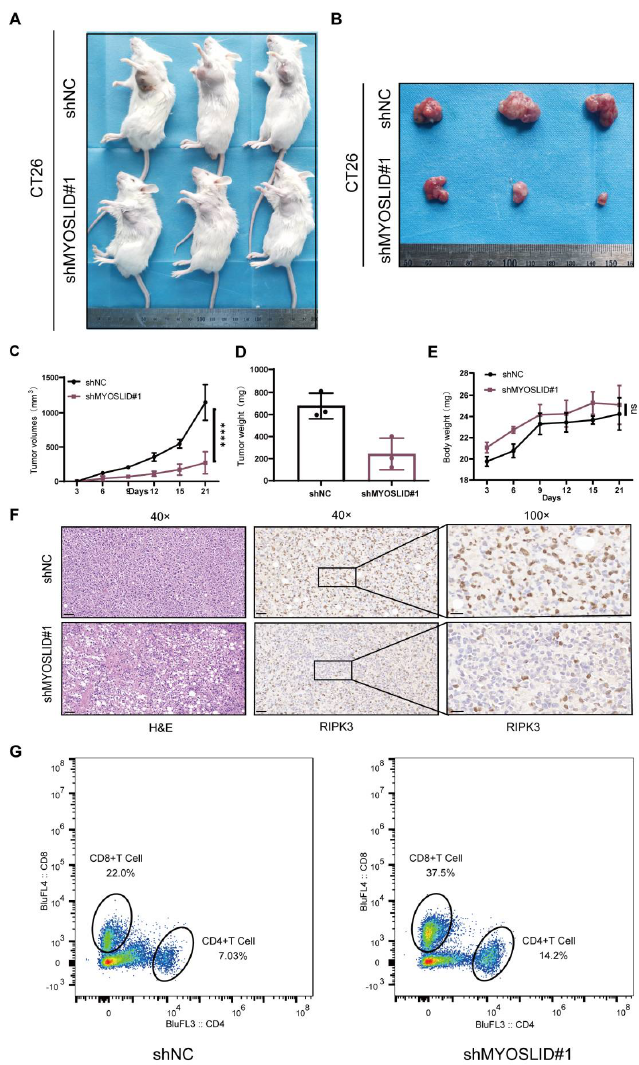
Figure 11. ( A , B ) Photos of subcutaneous neoplasia in the shMYOSLID group ( top ) and control group ( bottom ). ( C , D ) Tumour volume and tumour weight of subcutaneous neoplasia in the two groups. ( E ) Body weight of mice in each group. ( F ) H&E staining and immunohistochemical staining to detect the expression levels of RIPK3 in subcutaneous neoplasia of each group. ( G ) Flow cytometry analysis revealed significantly lower levels of CD4 + T and CD8 + T cells in the shMYOSLID group than in the control group.